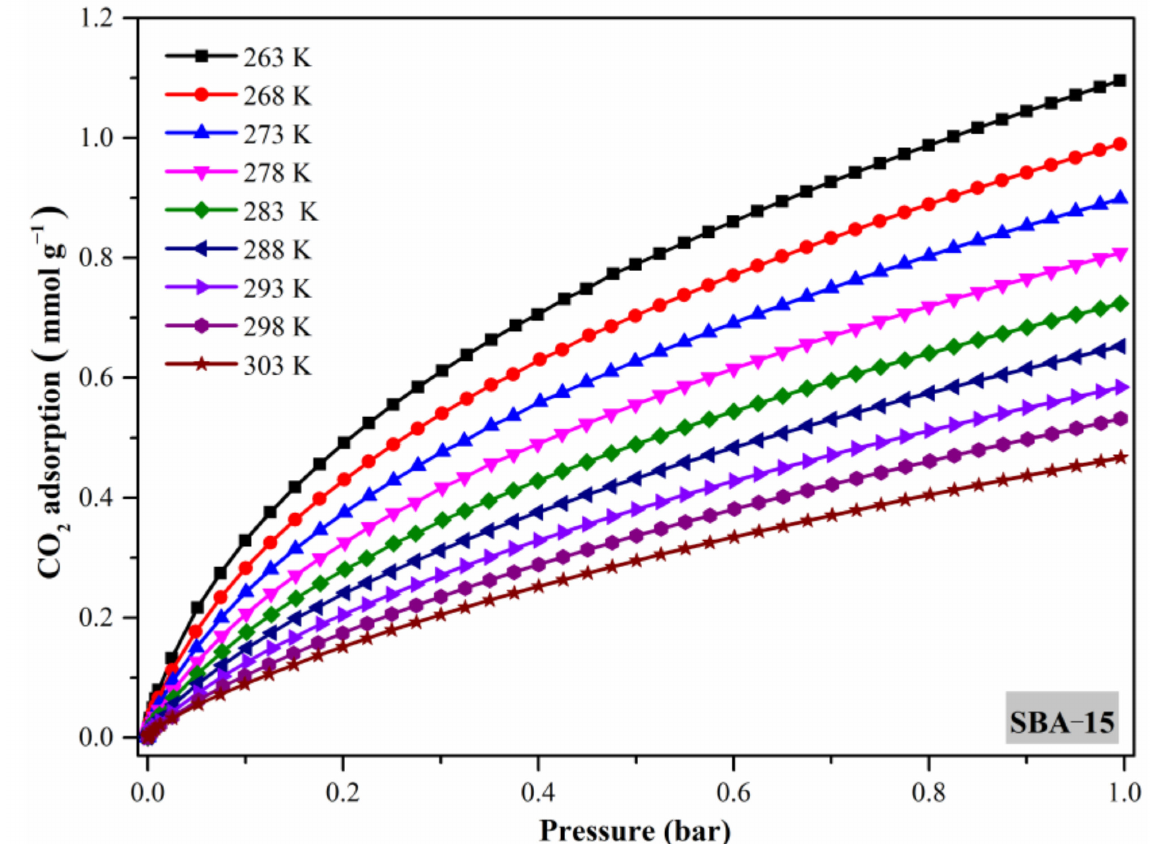
Figure 9. CO 2 isotherms of SBA-15 calcinated at 623